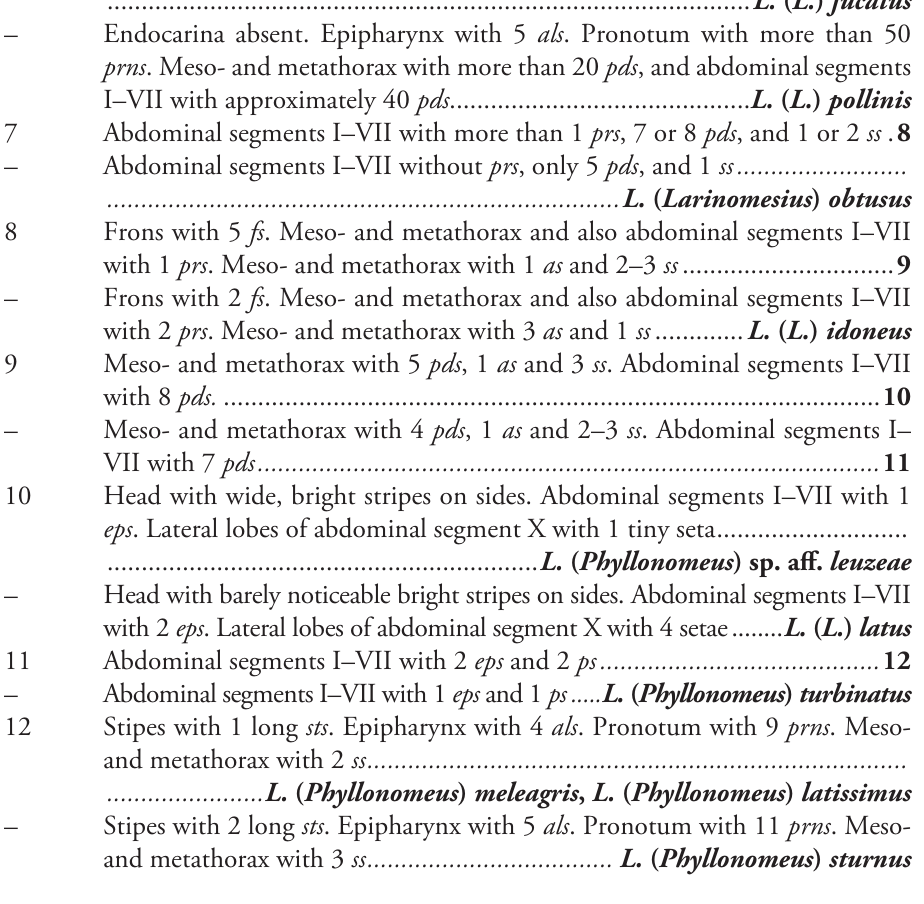
Pupae The following key is based on the pupa of L. vulpes described in this paper and on seven descriptions of pupae of the genus Larinus published previously (Zotov 2009a, 2010; Gosik and Skuhrovec